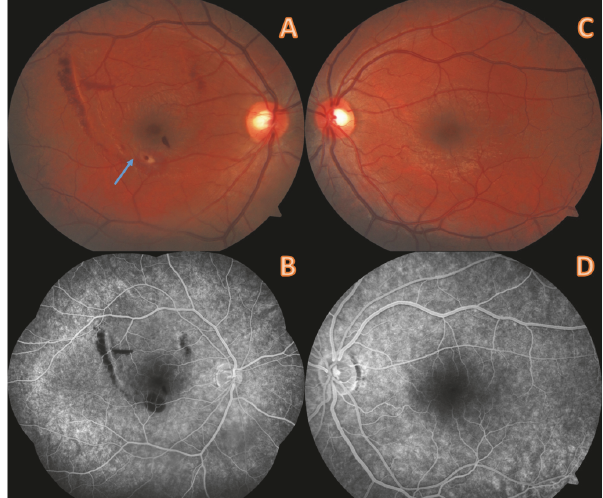
Figure 2: First day of examination of the patient in our clinic. (A) A retinal pigment epithelium (RPE) alteration was seen at the margin of the inferior temporal arterial vascular arcade in the right eye (blue arrow) and resolved preretinal and subretinal hemorrhages were also seen. (B) Fundus fluorescein angiography of the same eye. (C- D) Normal macula of the left